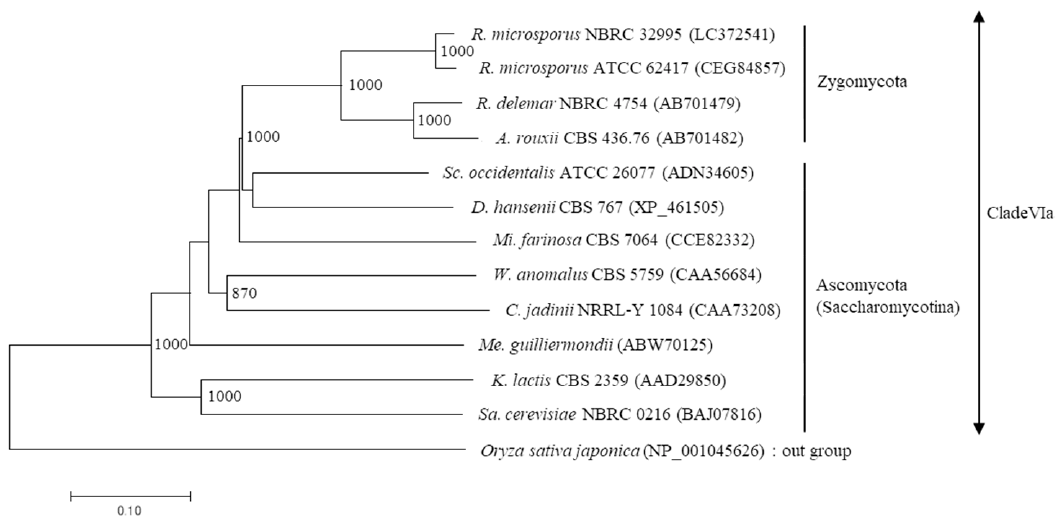
Figure 4. Phylogenetic analyses of the amino acid sequences of microbial β -fructofuranosidases. A dendrogram was constructed using the neighbor-joining method from the amino acid sequences of microbial β -fructofuranosidases belonging to clade VIa. The length of each branch indicates amino acid sequence divergence. Bootstrap values (>800), calculated from 1000 replications, are shown. The numbers in parentheses indicate the accession number.